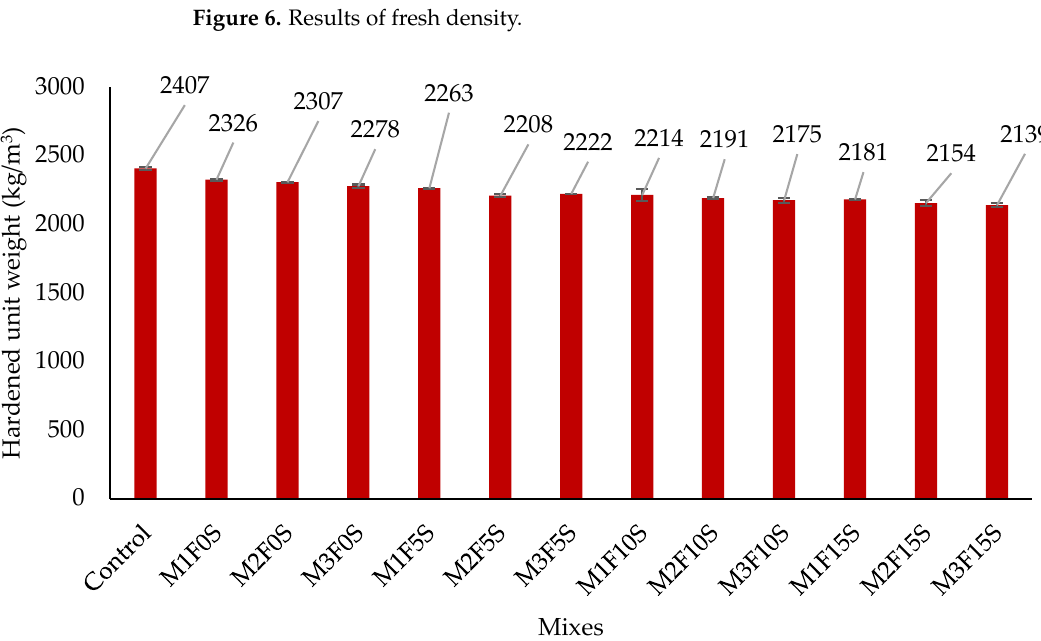
Figure 7. Results of hardened unit weight.